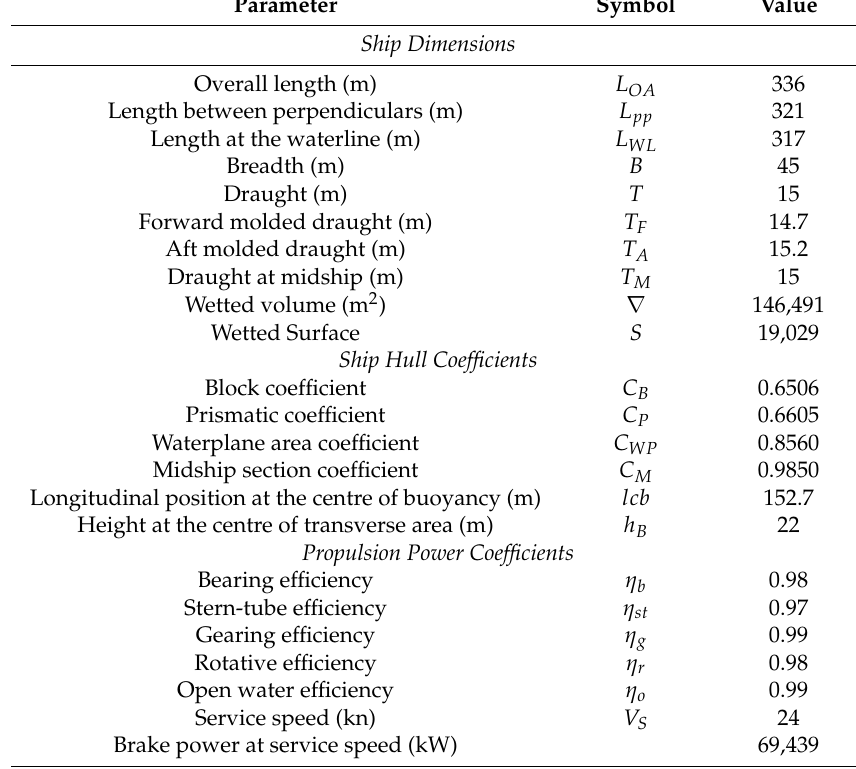
Table 19. Vessel dimensions propulsion power and related coefficients for